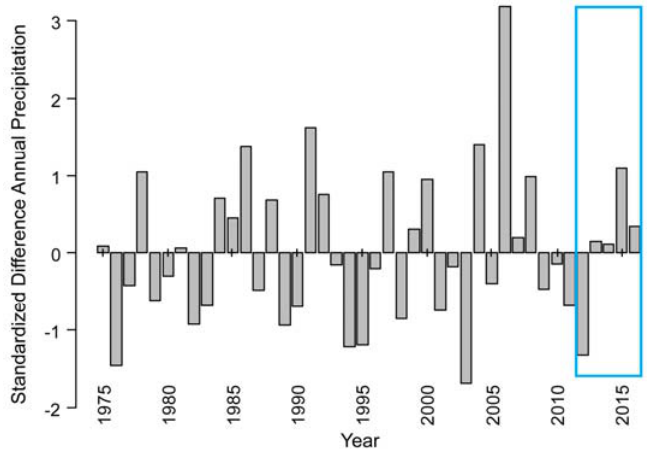
Figure 1. Standardized difference from long-term (1970–2016) mean rainfall on the Jornada Experimental Range (JER). Standardized difference is the individual year value minus long-term average (237.2 mm) divided by the standard deviation (SD 79.6 mm). The five-year study period (2012–2016) is delineated by the blue